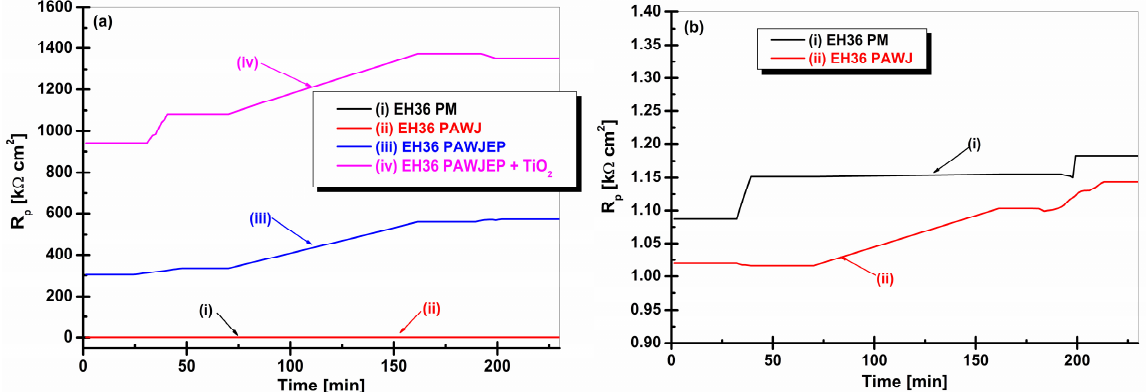
Figure 8. The evolution of R p values during immersion time ( a ) of: (i) EH36PM without protective coating used like parent material, (ii) EH36PAWJ welded steel without protective coating, (iii) EH36PAWJEP coated with polymeric primer and (iv) EH36PAWJEP + TiO 2 coated with nanocomposite polymeric primer reinforced with dispersed TiO 2 nanoparticles and ( b ) zoom in low polarization resistance value for (i) and (ii).